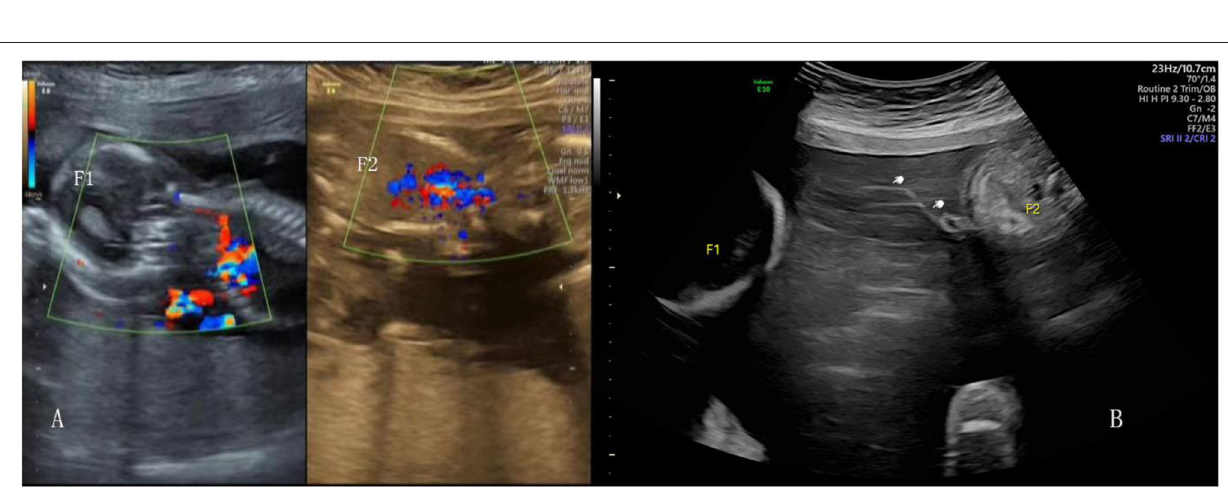
FIGURE 2 | Ultrasound image of the surviving twin after RFA (A) . Ultrasound image of TTTS, the donor amnion (white hand) floating in the amniotic cavity (B) .